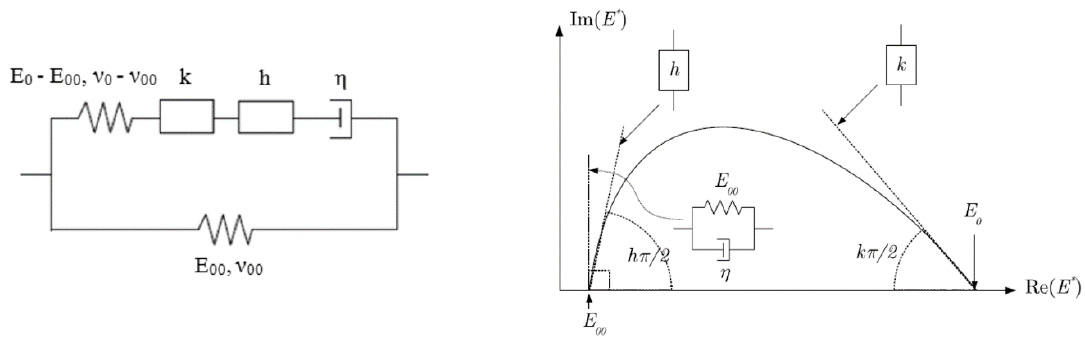
Figure 7. Analogical representation of the 2S2P1D Model (left) 12 and graphical representation of the model’s parameters on a Cole-Cole diagram (right).